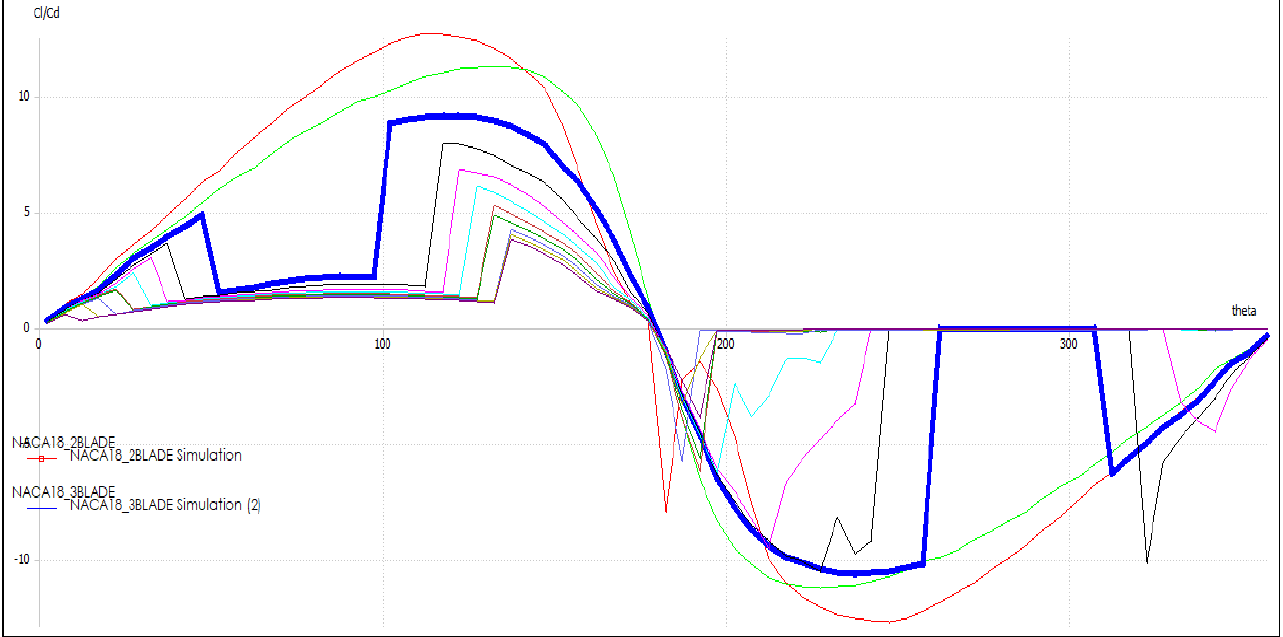
Figure 28. Cl/Cd vs theta plot of bottom-section for TSR